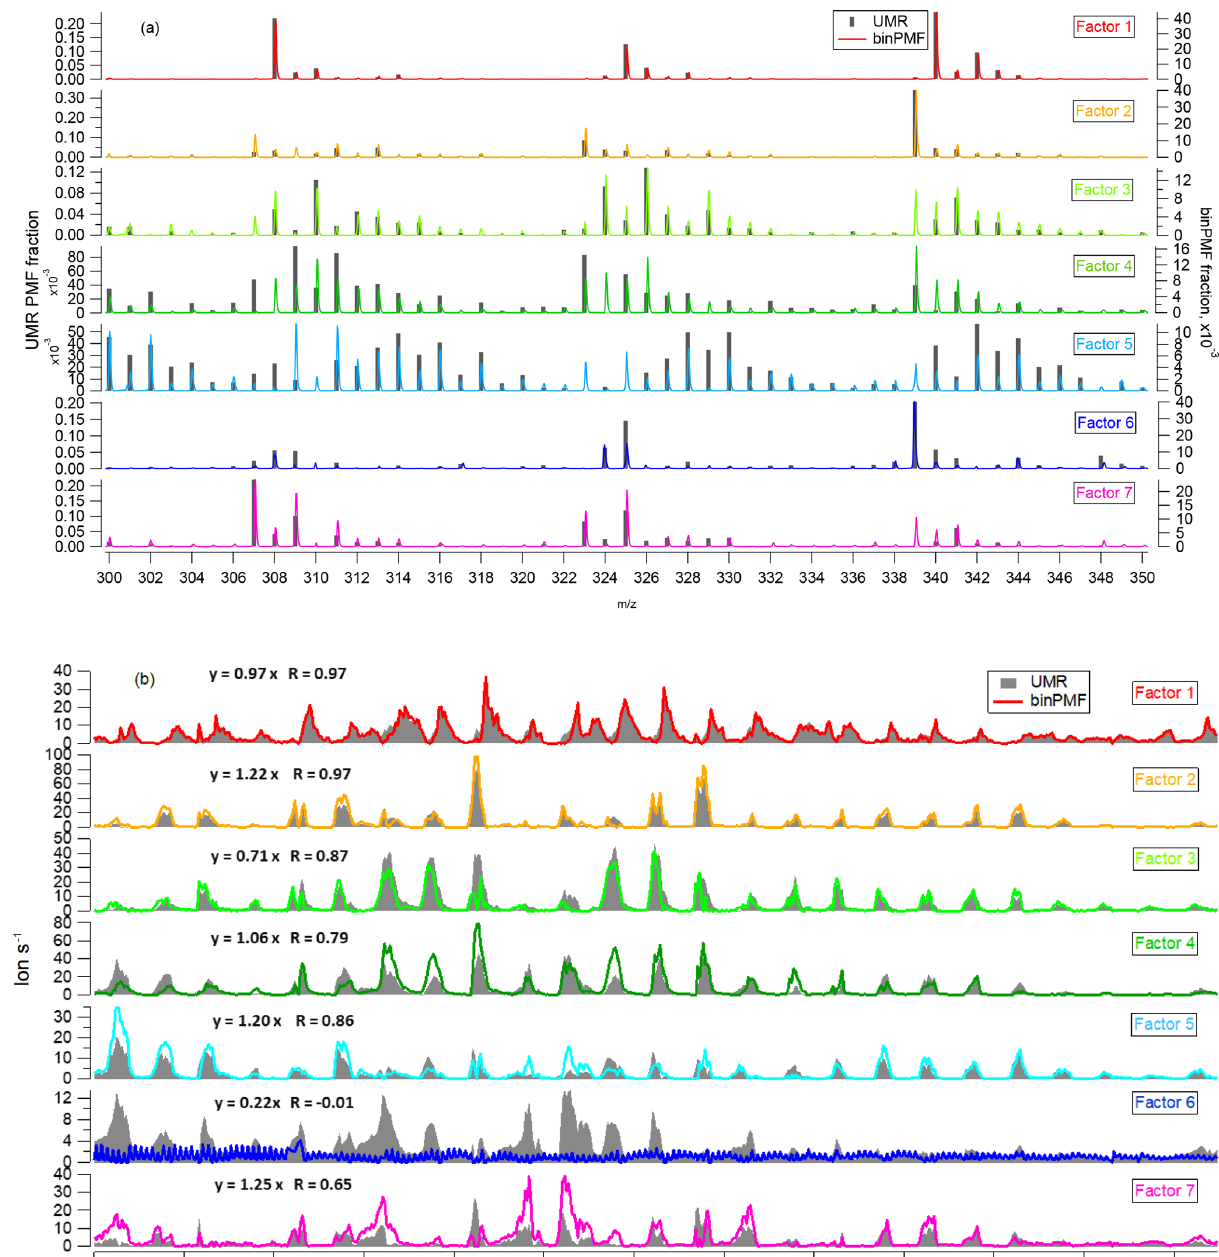
Figure 7. Comparison of binPMF and UMR-PMF for factor mass spectral profiles (a) and time series (b) . The equations in each panel describe how signals from binPMF ( y ) compare with the UMR-PMF solution ( x ). R is the correlation coefficient between the time